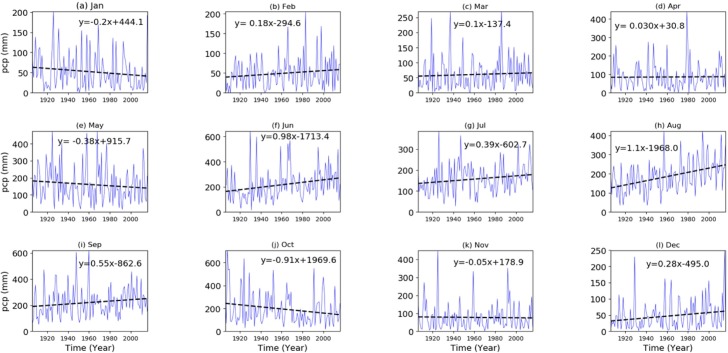
Monthly rainfall regression analysis.